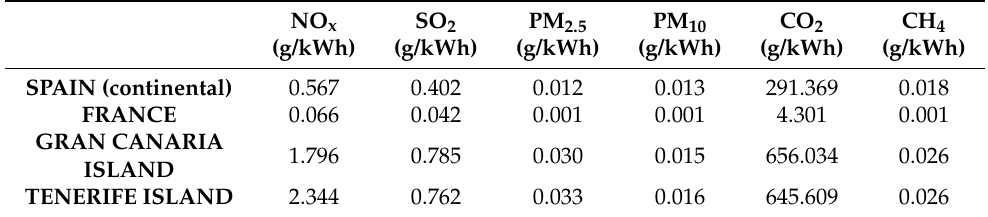
Table 5. Average emission factor for European grids in 2017.